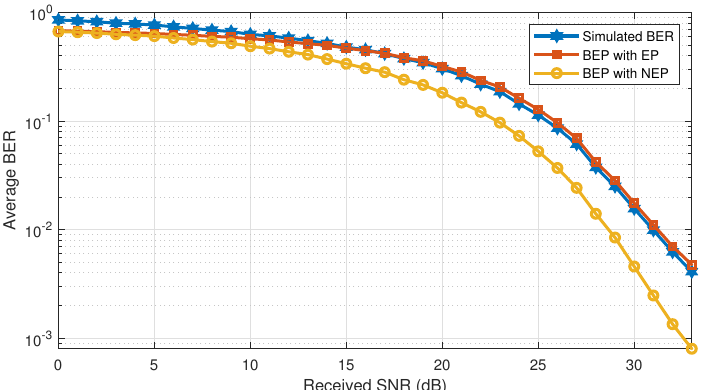
Figure 2. Performance comparison of the simulated BER and the analytical BEP for an AWGN channel with different users’ path loss and equal transmission